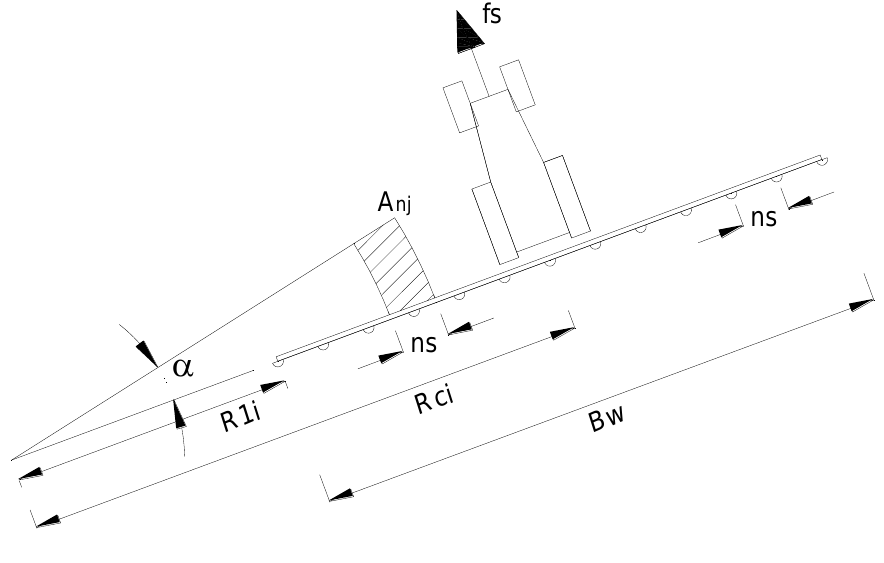
Figure 1. Work parameters of a boom sprayer following a circular trajectory. Rci = radius of the tractor axle to the center of the circumference i of the circular trajectory being considered; R1i = distance of the first nozzle on the boom to the center of the circumference plotted by the tractor on the i-th pass; Bw = width of the boom; ns = nozzle separation;  = angle traveled by the tractor per unit time; fs = displacement velocity of the tractor; and Anj = area treated by nozzle j per unit time assuming a work width of each nozzle with a value of ns and a linear displacement velocity of the tractor of